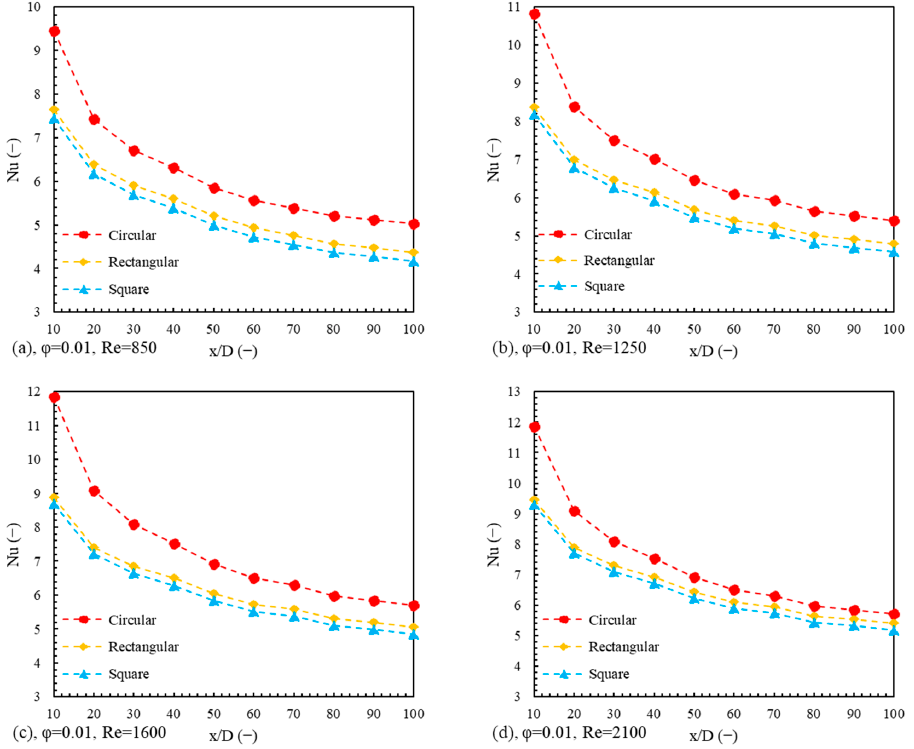
Figure 4. Local Nu of 1% nanofluid with different cross-sections in ( a ) Re = 850, ( b ) Re = 1250, Figure 4. Local 𝑁𝑢 of 1% nanofluid with different cross-sections in ( a ) 𝑅𝑒 = 850 , ( b ) 𝑅𝑒 = 1250 , ( c ) 𝑅𝑒 = 1600 , and ( d ) 𝑅𝑒 = 2100 . ( c ) Re = 1600, and ( d ) Re = 2100.